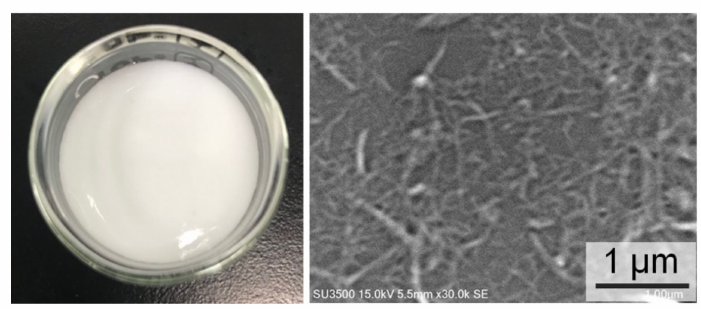
Figure 3. Suspension of CNF in water and its SEM image at × 30,000